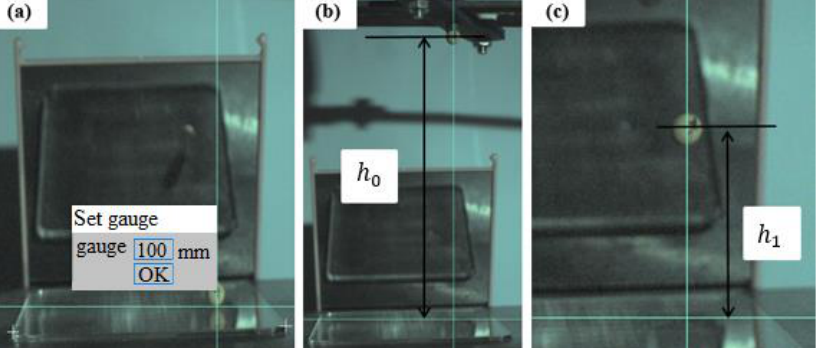
Figure 4. PCC image analysis process: ( a ) coordinate origin selection and distance calibration, ( b ) the distance between the initial position and coordinate origin of soybean seed particles, and ( c ) the distance between the highest point and coordinate origin of the first vertical rebound of soybean seed particles.